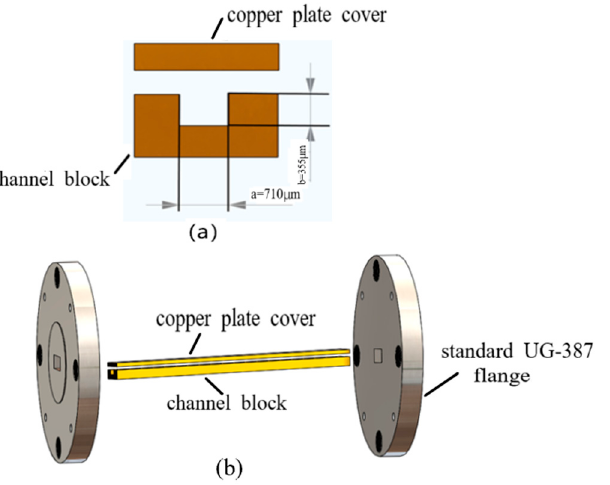
Figure 1. ( a ) A cross ‐ sectional dimension of a WR2.8 rectangular waveguide: a = 710 μ m and b = 355 μ m. ( b ) A WR2.8 waveguide is composed of three parts: a channel block, a copper plate cover and standard UG ‐ 387 flanges.